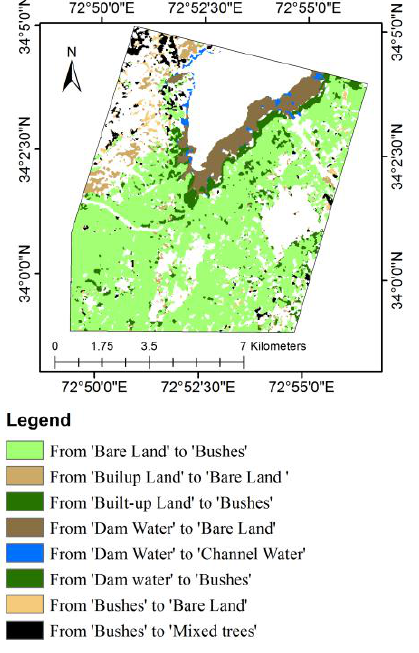
Figure 2. Change detection results of OLI SVM classified data from winter to spring 3.4 Change Detection from Winter to Summer (Case 2) Change detection matrix (Table 3) shows decrease of spatial distribution of bare land 16.01%, dam water 32.52%, built-up land 40.3 and increase of mixed trees 22.1%, channel water 181.5% and bushes 121.5%. Figure 3 shows a change of category from dam water to channel water, dam water to bare land. Similarly, a change of category from bare land to bushes, built-up land to bare land, bushes to mixed trees resulted increases of vegetation in summer compared to winter. A change of category from mixed trees to dam water resulted near the shoreline. Change of category from bare land to built-up is due to seasonal variation. Change detection from winter to summer resulted reduction in dam water mapping and increase of